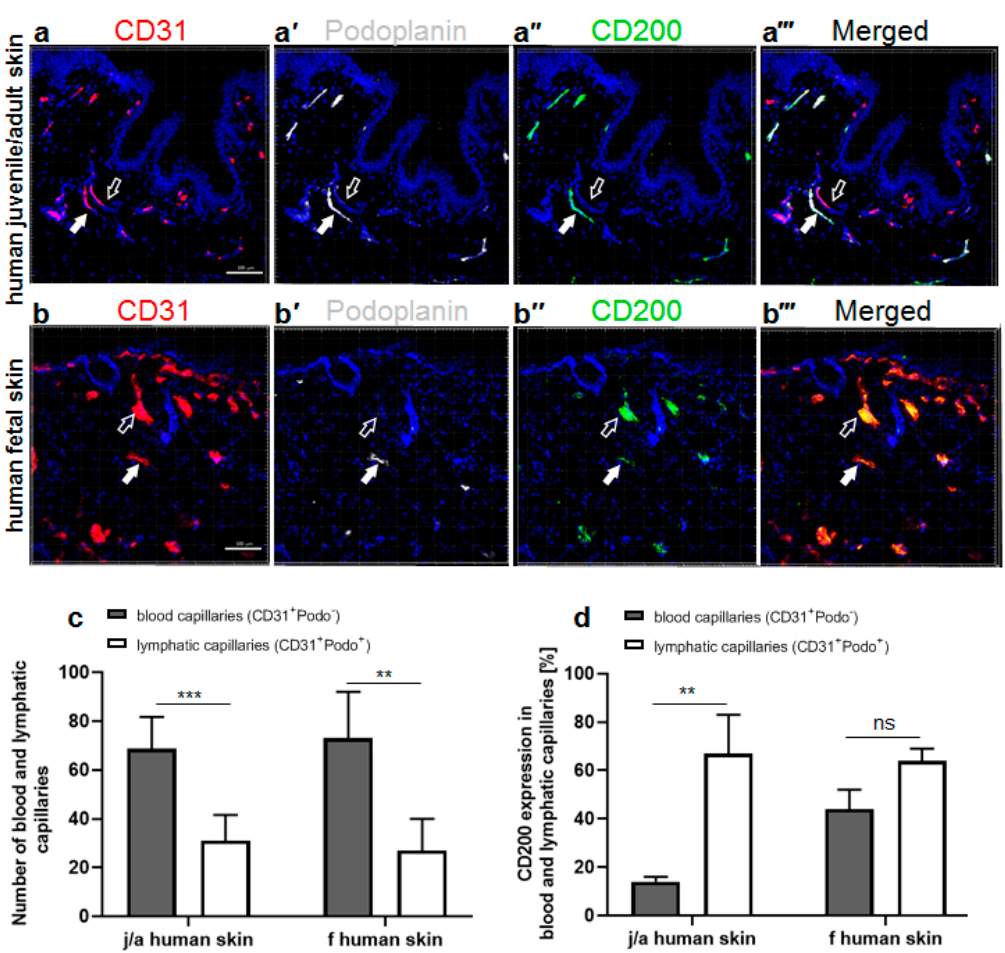
Figure 1. Evaluation of CD200 expression in normal human juvenile/adult and fetal skin. ( a – a”’ ) Immunofluorescence triple staining of juvenile/adult (j/a) human skin with antibodies against CD31 ( a ) for human blood capillaries (red), podoplanin ( a’ ) depicting human lymphatic endothelium (white), and CD200 ( a” ) (green). ( a”’ ) represents a merged confocal Z stack. Whereas blood capillaries stain only CD31 + (empty arrows), lymphatic capillaries are CD31 + Podo + (white arrows). Note the presence of blood capillaries (CD31 + Podo − ) which are mainly negative for CD200 (empty arrows), as well as the presence of lymphatic capillaries (CD31 + Podo + ) showing the expression of CD200 marker (white filled arrows). ( b – b”’ ) Immunofluorescence triple staining of human fetal skin (f skin) against CD31 ( b ) delineating human blood capillaries (red), podoplanin ( b’ ) depicting human lymphatic capillaries (white), and CD200 ( b” ) (green). Note the presence of blood and lymphatic capillaries expressing CD200 (empty and filled white arrows, respectively). ( b”’ ) represents a merged overlay. ( c ) Quantification of blood and lymphatic capillaries in j/a and f skin. In the dermis of j/a, blood capillaries constitute approximately 68.8 ± 13%, whereas lymphatic endothelium represents 31.0 ± 10.6% of all vessels present in this skin type (*** p < 0.0001). In the f skin, blood endothelium comprises 73.0 ± 19% while lymphatic vessels constitute 27.0 ± 13% of all capillaries (** p < 0.001). ( d ) Quantification of CD200 expression on blood and lymphatic capillaries of j/a or f skin. Note the significantly higher expression of CD200 on j/a lymphatic capillaries as compared to the j/a blood capillaries (67.0 ± 16% vs. 14.0 ± 2.0%, respectively, *** p < 0.0001), whereas the expression of CD200 was similar in blood and lymphatic capillaries of human f skin (44.0 ± 8.0% vs. 64.0 ± 5.0%, respectively, p = ns), n = 5 independent j/a and fetal skin donors each. Cell nuclei are stained with Hoechst (blue). Scale bars 100 μ m.